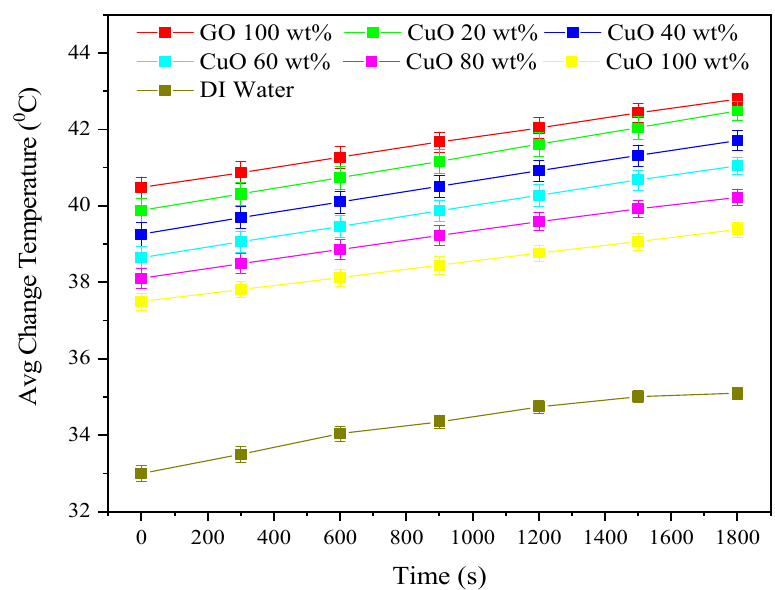
Figure 6. Average change temperature profile of DI water base binary CuO–GO nanofluids at 0.0004 wt %.